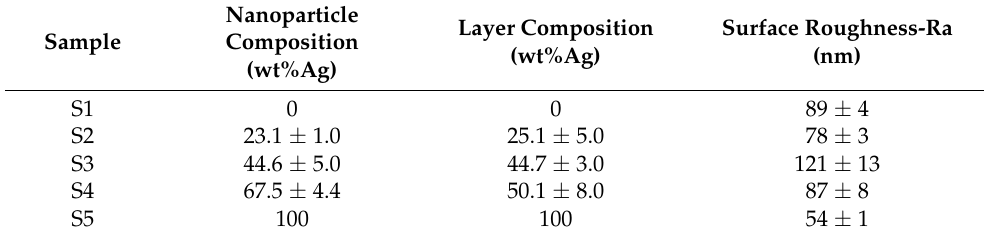
Table 3. Surface roughness (Ra), and composition values of the